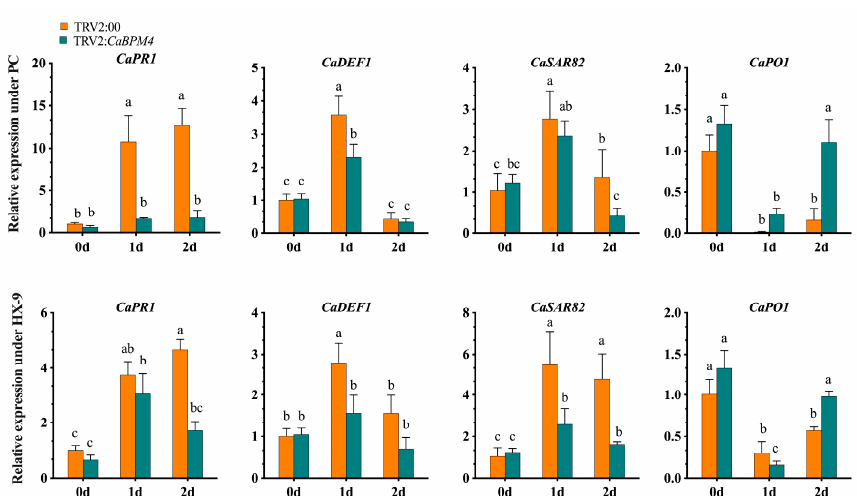
Figure 7. Silencing of CaBPM4 reduced the expression of defense defense-related genes in pepper at 1 d post-inoculation with PC and HX-9 strains of P. capsici . Relative expression levels of the defense defense-related genes at different time point under P. capsici infection were determined in comparison with that in TRV2:00. Values are the means ± SD from three independent experiments. Small letters (a–c) represent significant differences ( p < 0.05).